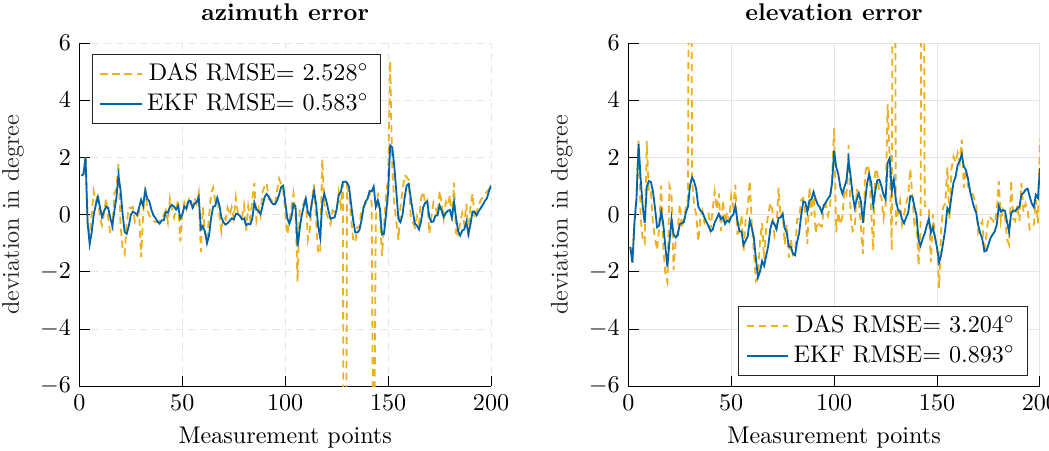
Figure 7. Deviation from the ideal angle for azimuth ( left ) and elevation ( right ) for the delay-and-sum (DAS) beamformer (yellow, dashed) and EKF-based approach (blue,